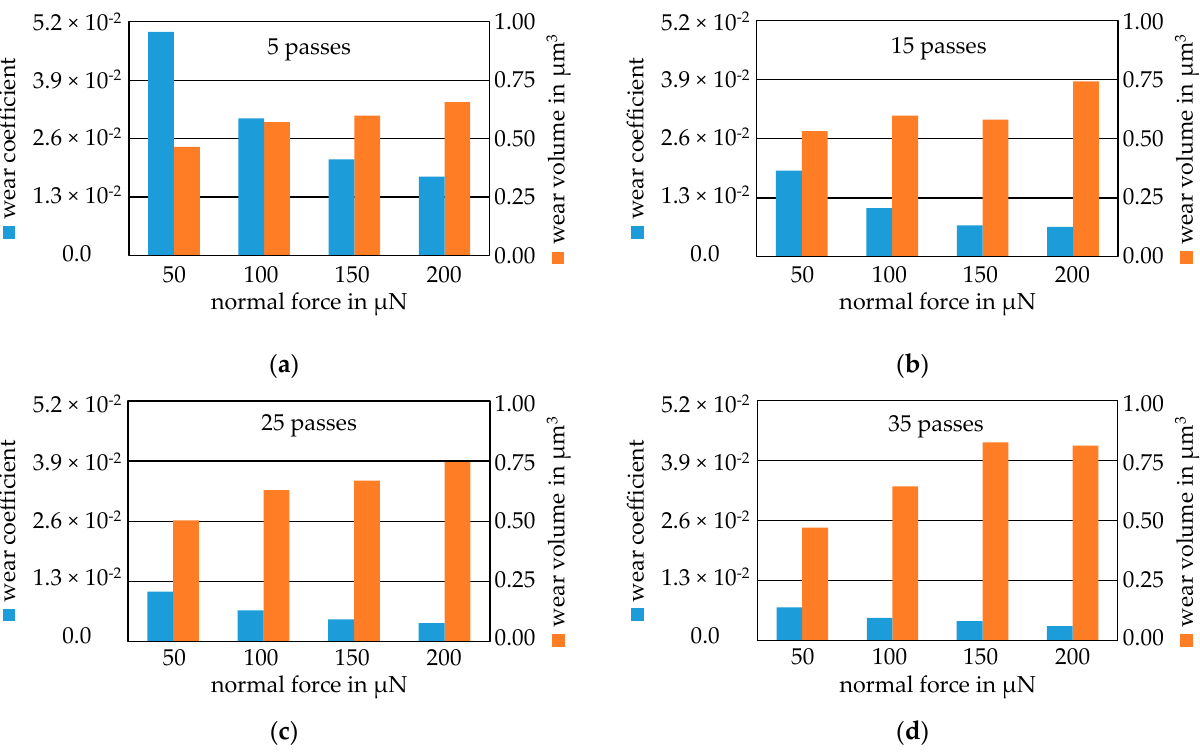
Figure A2. Determined wear volumes with standard deviation of the respective parameter combination. ( a ) Volume determination via subtraction of post-scan and pre-scan of the MoO 3 -coating. ( b ) Volume determination only via post-scan of the MoO 3 -coating.